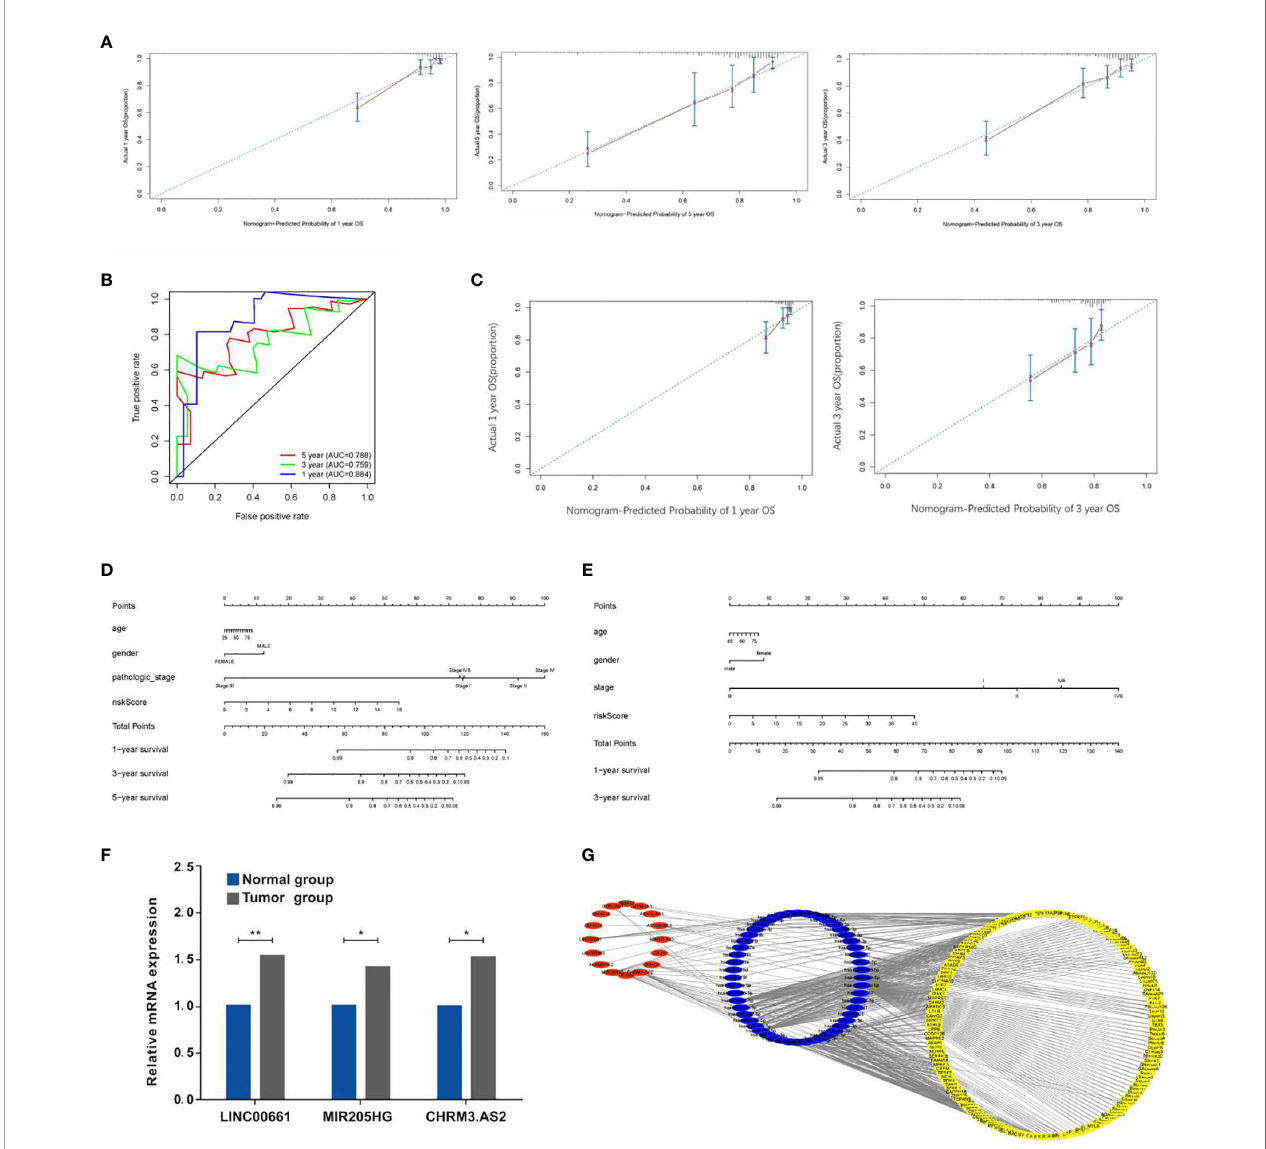
FIGURE 7 | (A) Calibration plots of the predictive accuracy of the nomogram for 1, 3, and 5 years in TCGA data. (B) Time-dependent ROC curve in TCGA data. (C) Calibration plots based on the GEO data. (D) Nomogram based on the signature and clinical information in the TCGA data. (E) Nomogram based on the signature and clinical information in the GEO data. (F) qRT-PCR detection of the expressions of LINC00661, MIR205HG, and CHRM3.AS. (G) Construction of lncRNA-miRNA-mRNA regulatory network (*P < 0.05, **P <